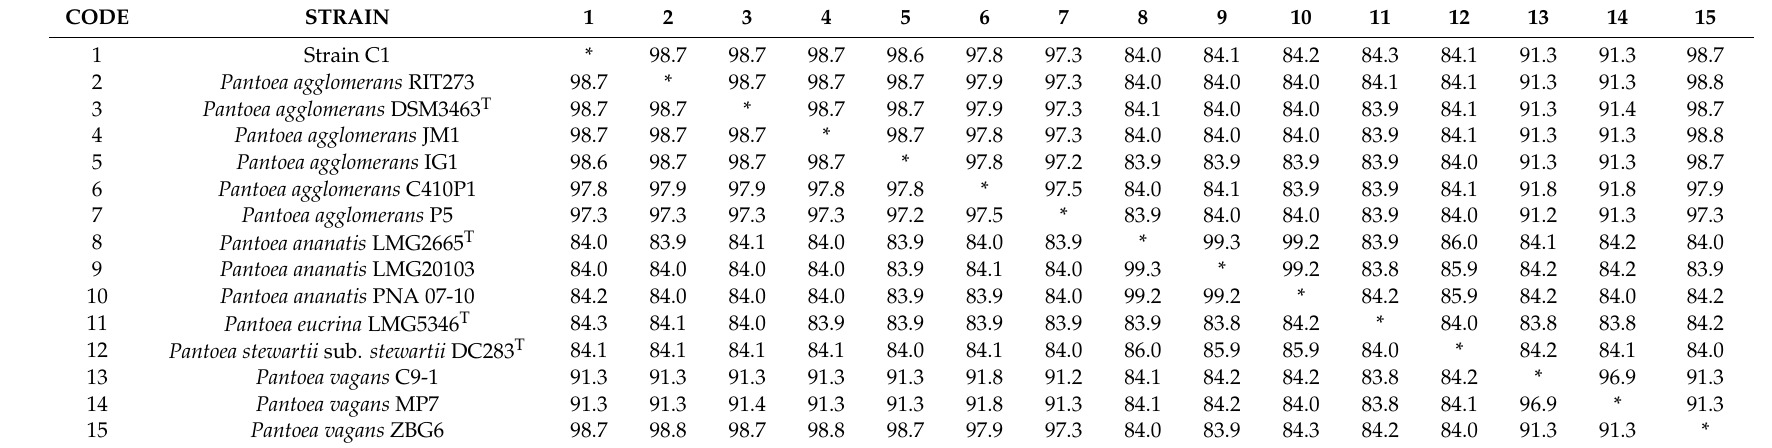
Table 2. Average Nucleotide Identity (ANI) values (in percentages) based on alignment of the whole genome of strain C1 and the most closely related members of the genus Pantoea